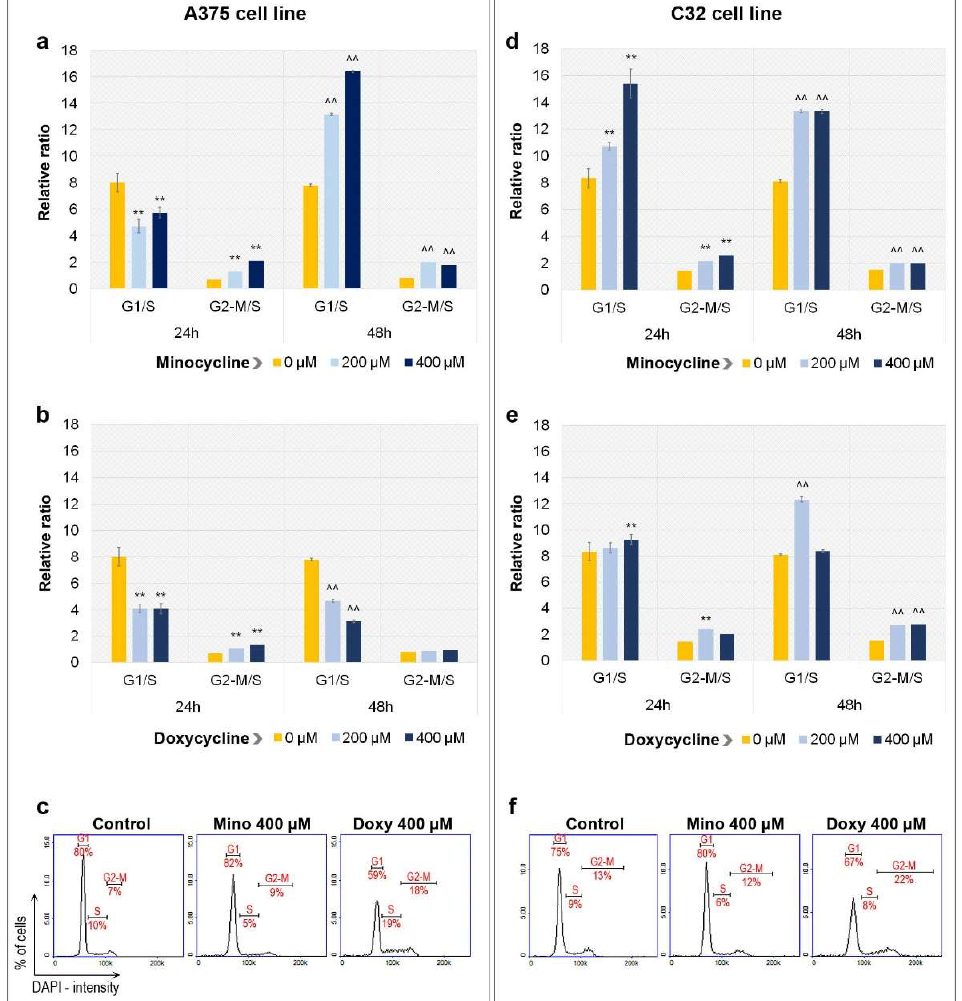
Figure 2. Influence of minocycline and doxycycline on cell cycle of tested amelanotic melanoma cells. The results of the analysis are presented as a relative ratio of G1/S and G2-M/S for A375 ( a , b ) and C32 ( d , e ) cell lines. Representative histograms indicate the distribution of tested cells in the individual phases of the cell cycle after 48 h treatment with the tested drugs ( c , f ). ** p < 0.005 vs. control 24 h; ^^ p < 0.005 vs. control 48 h.